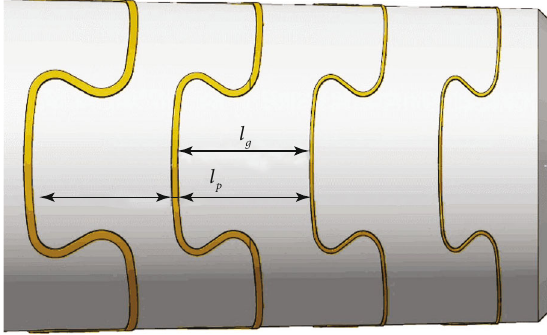
Figure 4: Pseudo-rigid body model of bionic